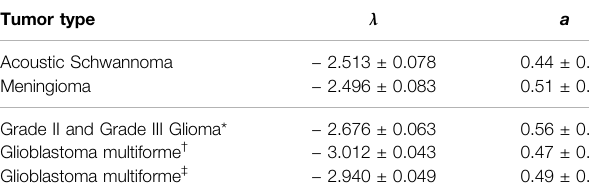
TABLE 5 | Visibility graphs results for different brain tumor